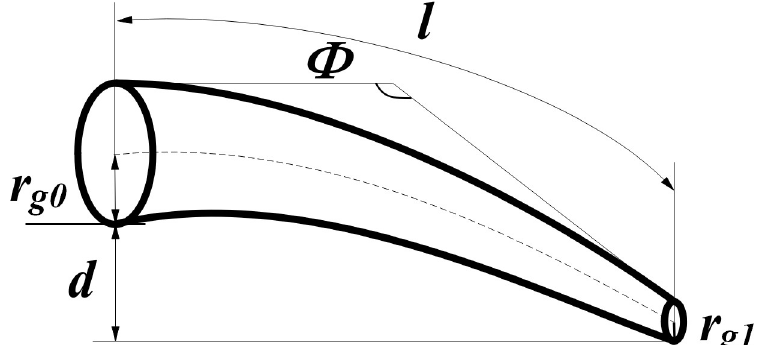
Fig 3. Root geometry